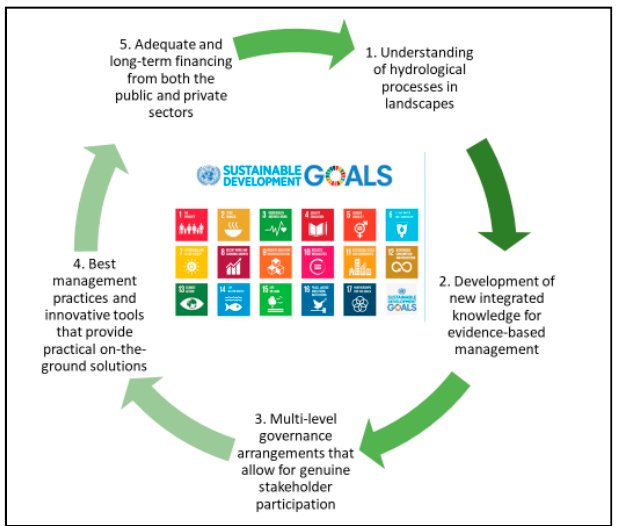
Figure 5. Factors to consider in restoration and sustainable management of productive landscapes.